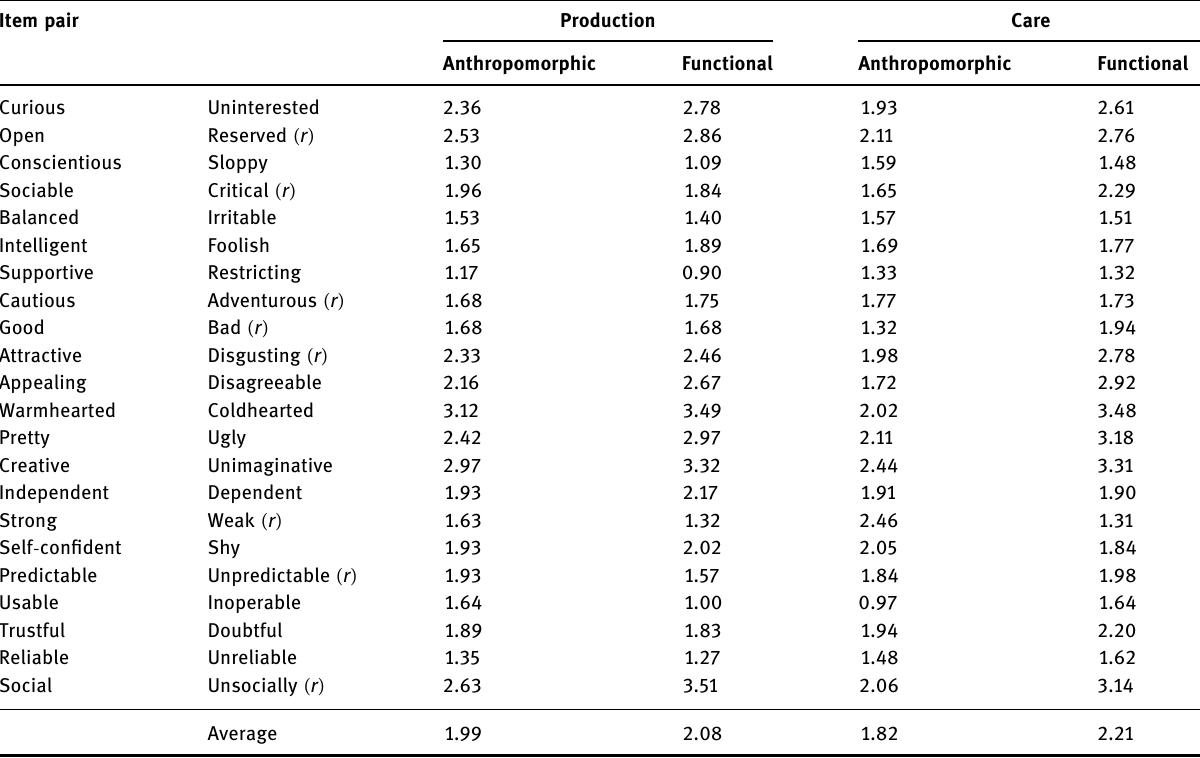
Table 2: Items and respective means of the semantic di ff erential from 0 to 5 points for evaluating the robotic designs and scenarios. Items with ( r ) were reversed in the survey. Lower numbers represent more positive evaluations.